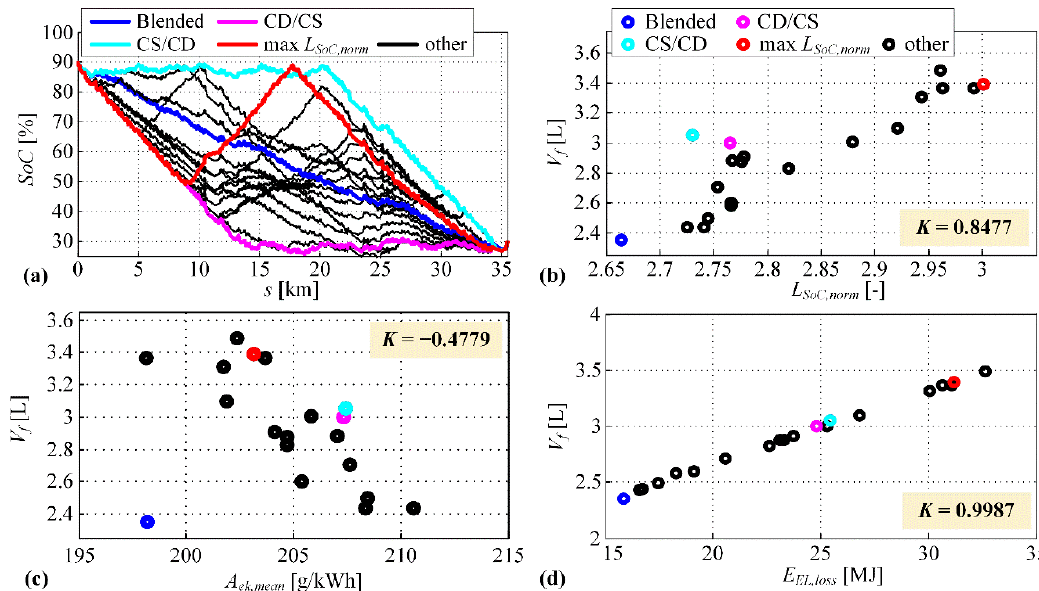
Figure 7. Set of DP optimal SoC trajectories of different lengths obtained by imposing an additional SoC constraint (14) ( a ); and corresponding total fuel consumption 𝑉 𝑓 shown with respect to normalized SoC trajectory length 𝐿 𝑆𝑜𝐶,𝑛𝑜𝑟𝑚 ( b ), mean engine specific fuel consumption 𝐴 𝑒𝑘,𝑚𝑒𝑎𝑛 ( c ), and total electric energy losses 𝐸 𝐸𝐿,𝑙𝑜𝑠𝑠 ( d ) (3 x DUB driving cycle when a zero road grade was used).